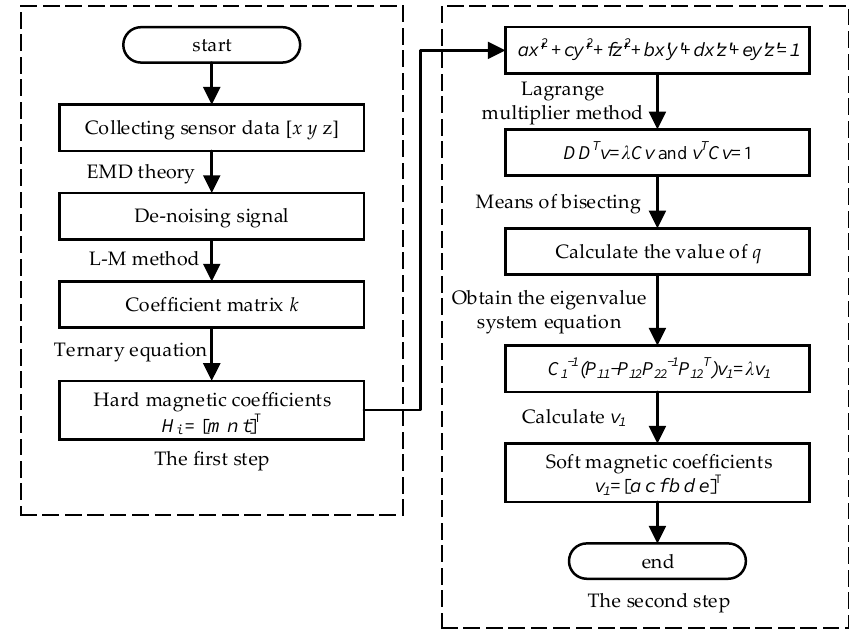
Figure 1. Algorithm flow chart for the geomagnetic measurement error correction.